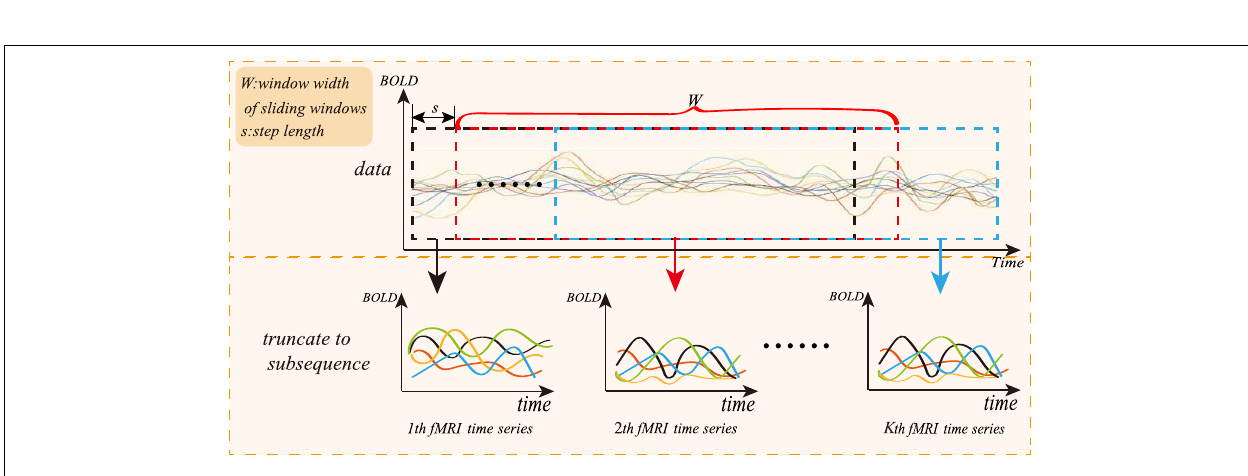
FIGURE 3 | Sliding window method diagram.